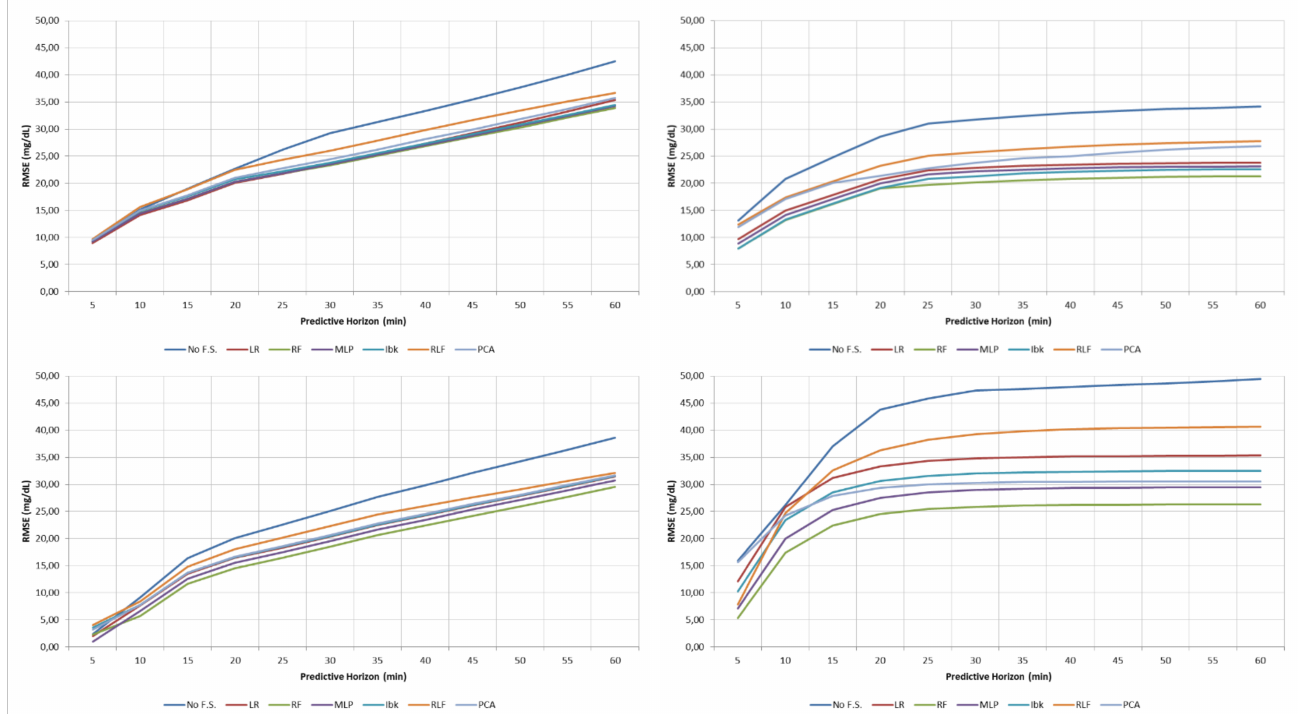
Figure 2. Test stage. RMSE up to 12-step glycemia forecasting. Averaged results of 25 subjects. Upper left, LR. Upper right, RF. Lower left, SVM. Lower right, GP. F.S.: Feature Selection; LR: Linear Regression; RF: Random Forest; SVM: Support Vector Machines; GP: Gaussian Process; MLP: Multi Layer Perceptron; IBk: Instance-Based K-nearest neighbor; Rlf: Relief Attribute; PCA: Principal Component